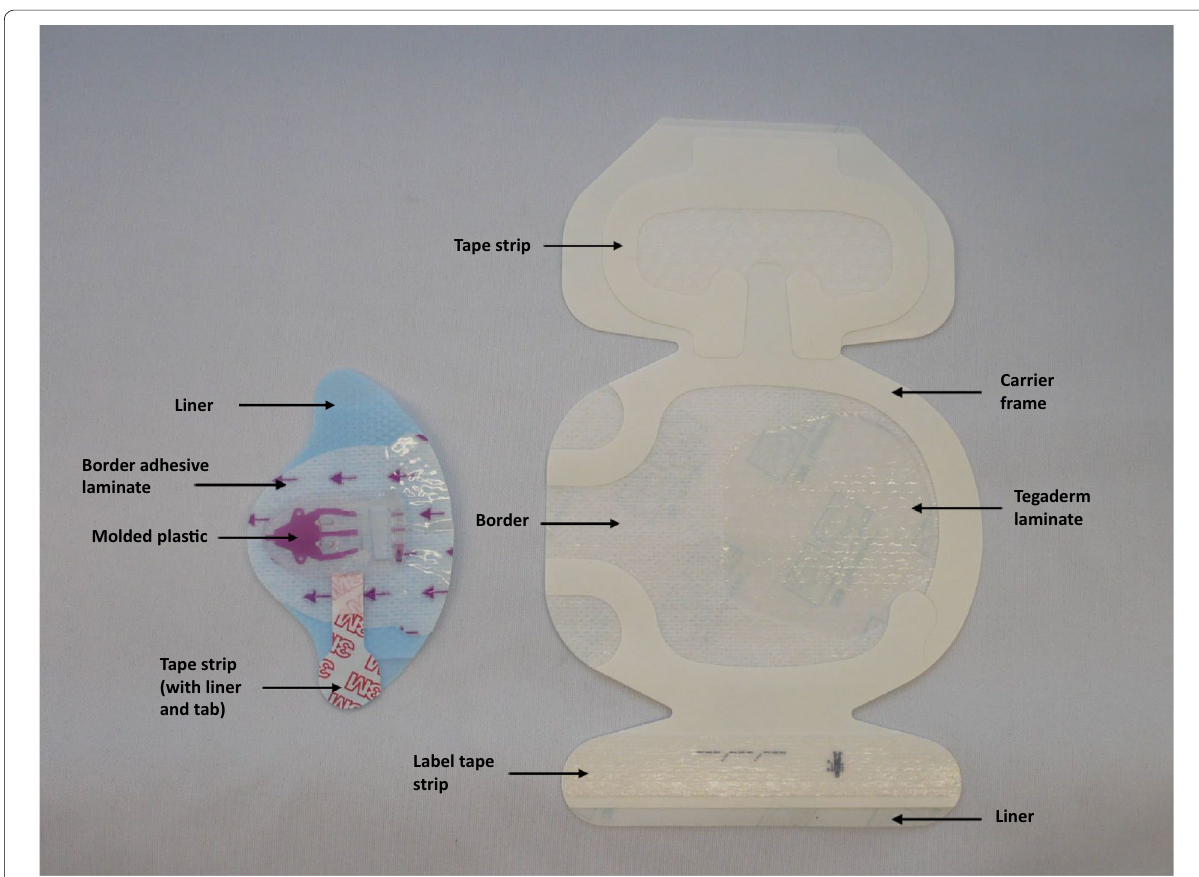
Fig. 1 3M ™ PICC/CVC Securement Device consisting of a moulded plastic device (size 5.1 cm a silicone adhesive (Tegaderm ™ IV Advanced Securement device, on the left) and a soft cloth bordered transparent film dressing (Tegaderm ™ IV Advanced Securement dressing, on the right; 8.5 cm